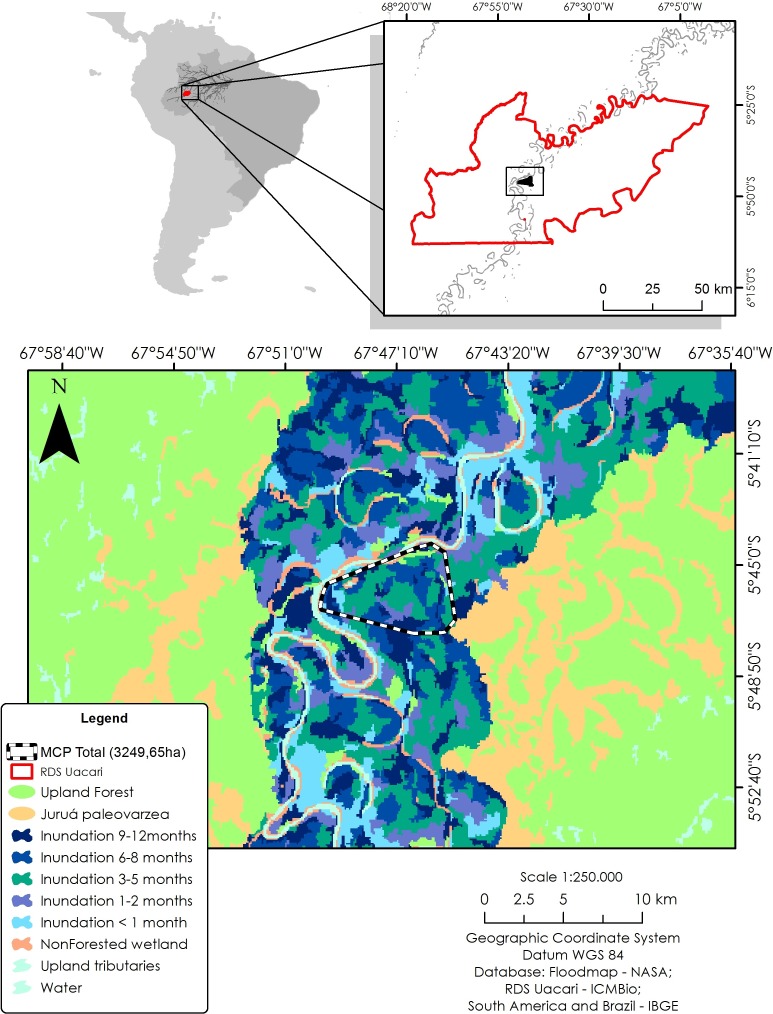
Study area in the Médio Juruá region of western Brazilian Amazonia, showing the forest and non-forest floodplain categories distinguished on the basis of ALOS ScanSAR images.Black–white line represents the 100% minimum convex polygon (MCP) for the three monitored individuals of C. globulosa across the study landscape.